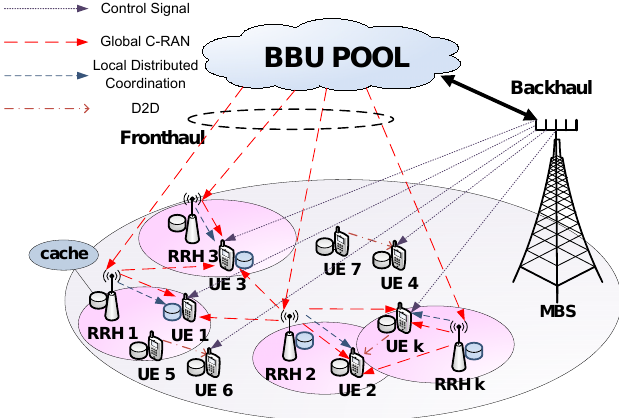
Fig. 1. The system model of a F-RAN. In the control plane the control signal is provided by the MBS while in the user plane, D2D, local distributed coordination, and global C-RAN can be chosen.